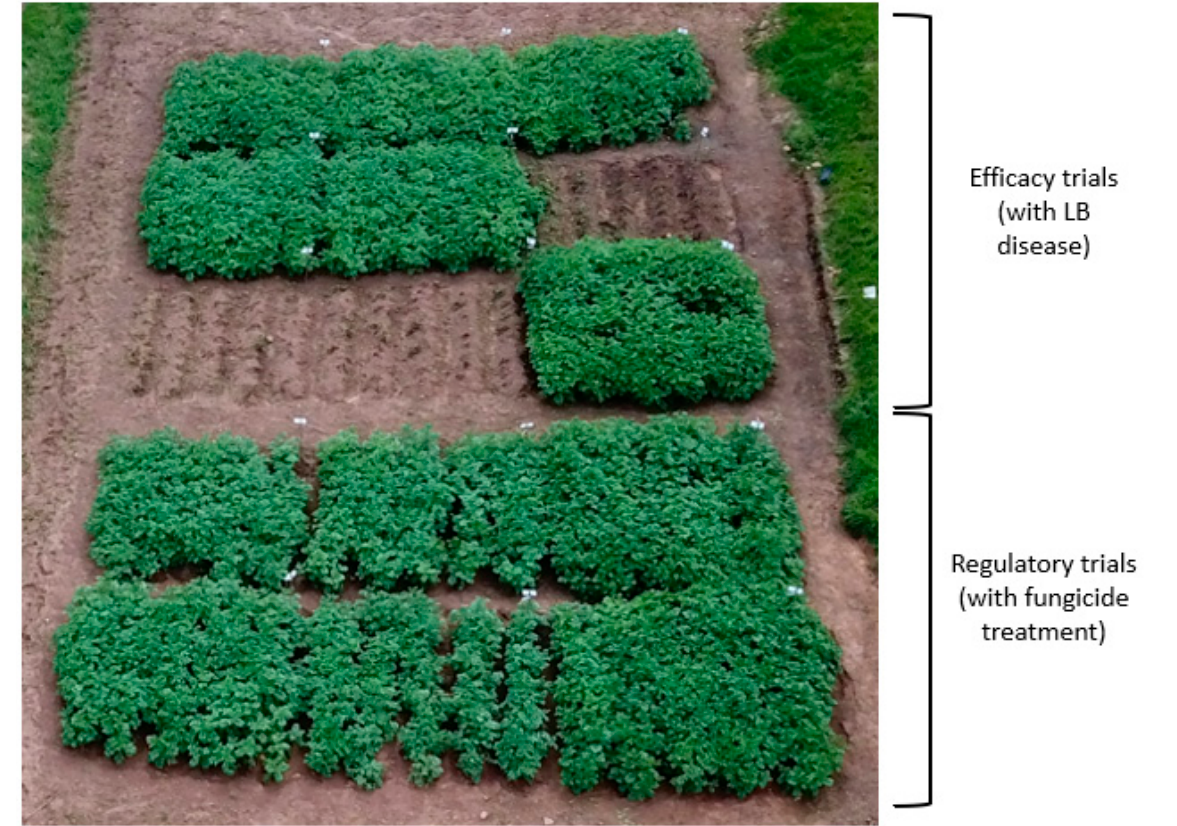
Figure 2. Confined field trial at Kachwekano ZARDI of plots with transgenic event Vic.172 and the variety Victoria. Efficacy trials were made of transgenic event plots (green plants) and Victoria plots (moribund plants), which were devastated by LB under natural infestation. Regulatory trials consisted of plots of the transgenic event Vic.172 and the variety Victoria under fungicide treatment (all green) during the short-rain season in 2019.